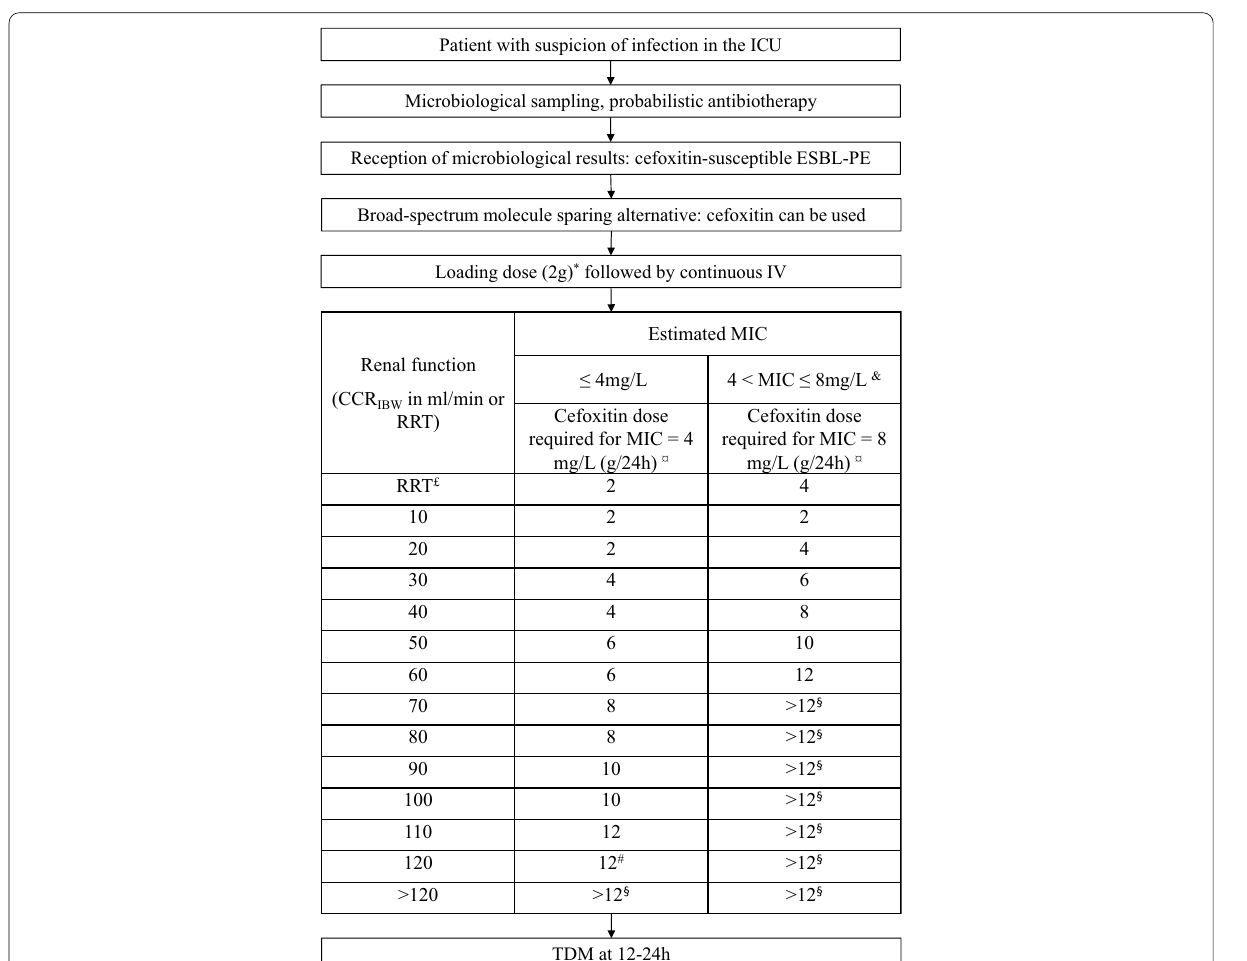
Fig. 2 Proposed decision and posologic algorithm for cefoxitin use in ICU patients with ESBL‑PE infection. * Proposed loading dose and consider measuring the MIC with E ‑test in this situation. ¤ Cefoxitin dosages required for achieving PTA the maximal possible value for MIC in this interval of estimation (i.e., 4 mg/L (left) and 8 mg/L (right)). £ Considering a continuous RRT and using standard parameters (blood flow rate 250 mL/min, ultrafiltration rate 2000 mL/h). # The computed PTA for CCR IBW 12 g/24 h was 89.5%, which was rounded to 90% and considered as acceptable. § The use of a dosage of cefoxitin above 12 g/24 h has not been reported so far. The absence of data concerning toxicity and uncertainty considering the possible non‑linear PK over such dosage should be